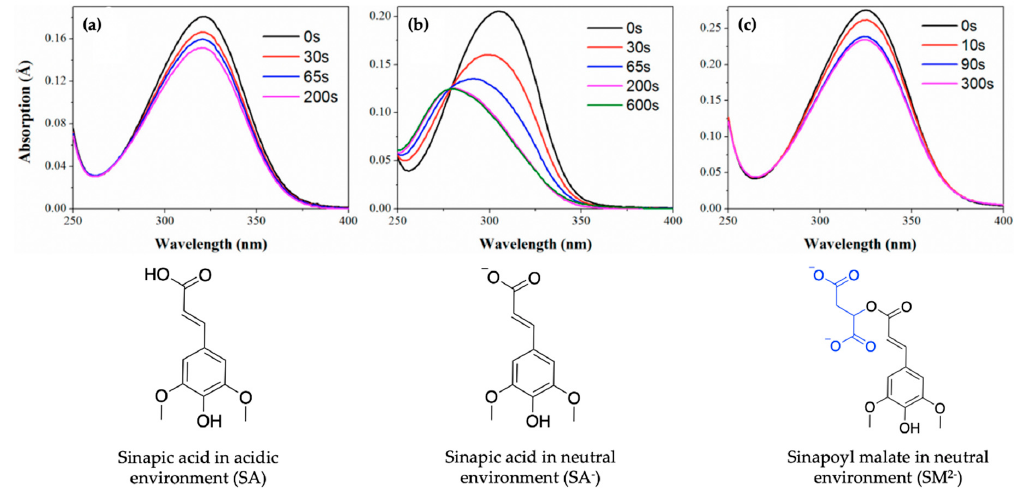
Figure 5. UV / visible spectra showing the photoisomerisation of ( a ) SA, ( b ) SA − and ( c ) SM 2 − , with the group added to SA shown in blue, at varying duration of pulsed irradiation. Corresponding structures are shown under UV / visible spectra. Reproduced and adapted with permission from [106]. © 2017 American Chemical Society.